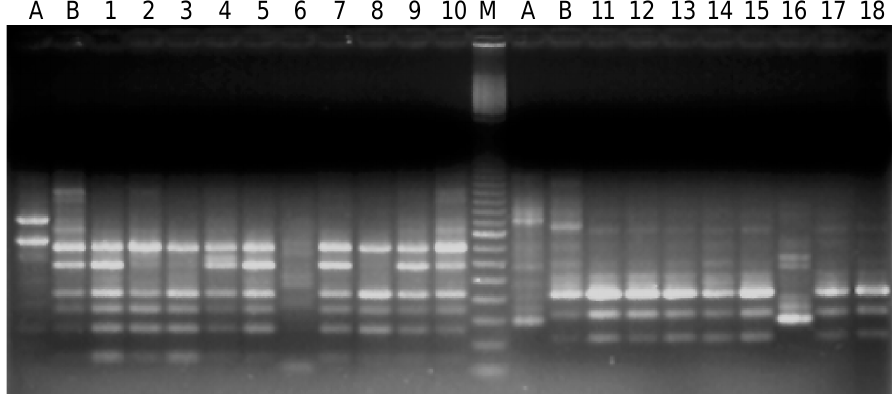
Figure 1 - A representative RAPD reaction set for the differentiation of whitefly biotypes. M: 100-bp DNA ladder (Amersham Pharmacia Biotech); samples on the left of the marker were amplified using primer OPA-04 and samples on the right of the marker using OPA-10. Lanes 1-6: Individual whiteflies from cabbage and lanes 7-10: individual whiteflies from melon. Lanes 11-14: Individual whiteflies from cabbage and lanes 15-18: individual whiteflies from melon. Standard biotypes (biotype A, Arizona, USA, and biotype B, California, USA) used for identification are indicated by the letters A and B,